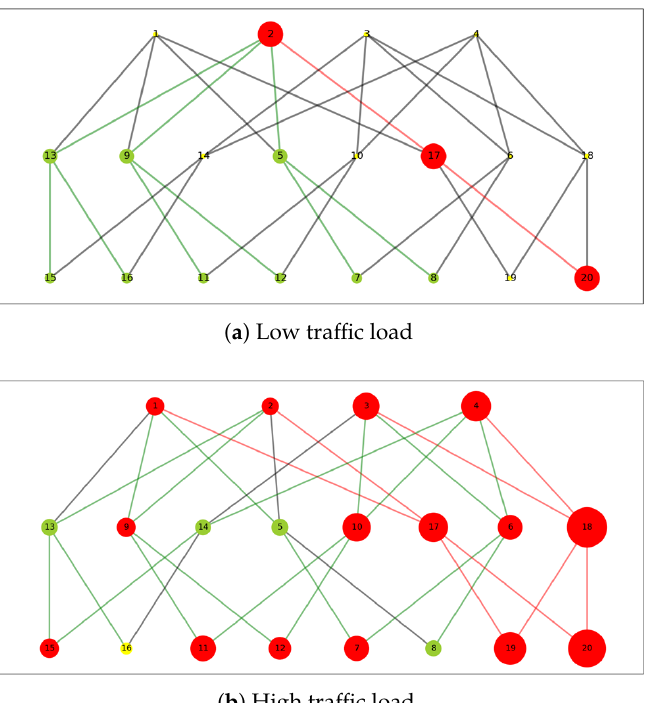
Figure 3. Forward ( – ), downward ( – ), and unused ( – ) paths are illustrated along with the cumulative traffic which is being served by DCN nodes: • > 10 Mb, • 500 kb–10 Mb, • < 500